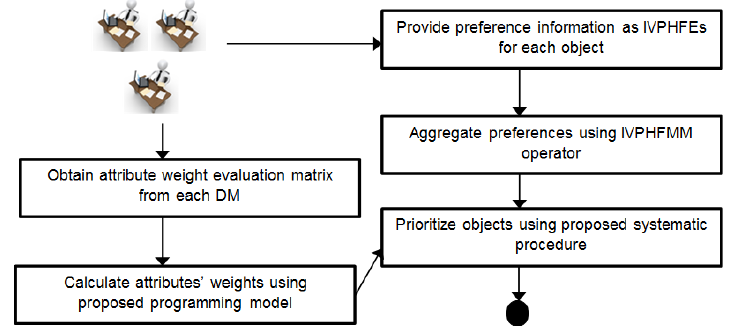
Figure 1. Proposed decision framework in the IVPHFS context.